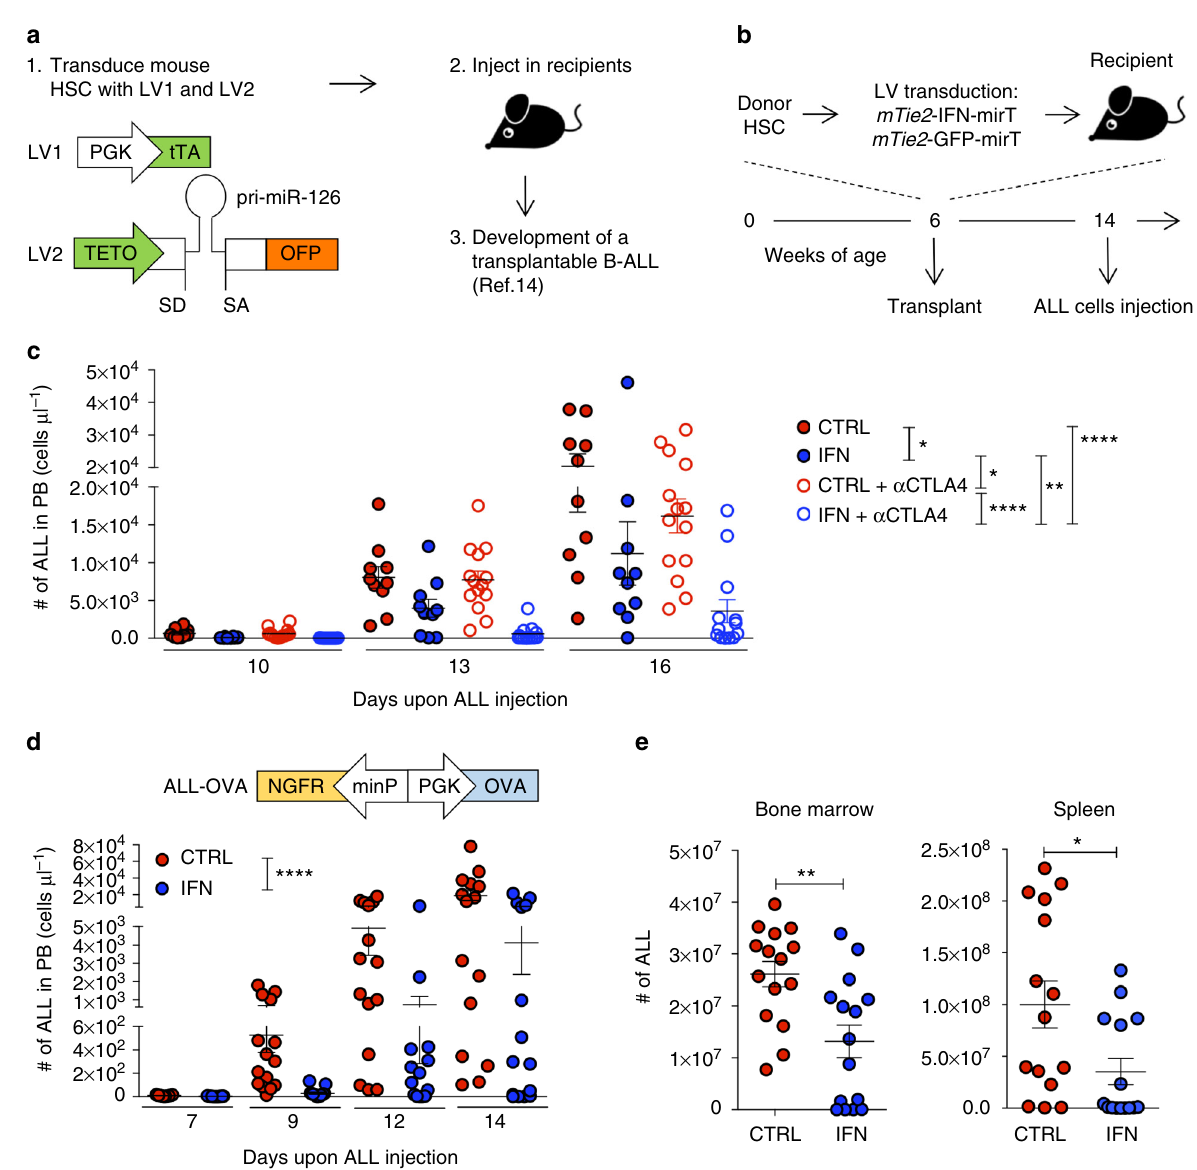
Fig. 1 IFN gene therapy inhibits ALL growth. a Schematic representation of the lentiviral vectors (LV) used to engineer HSC and generate spontaneous B- ALL. b Experimental design. c Absolute numbers (mean ± SEM) of parental ALL in the peripheral blood (PB) over time of CTRL ( n = 10, treated with isotype control antibody), IFN ( n = 10, treated with isotype control antibody), CTRL + α CTLA4 ( n = 14) and IFN + α CTLA4 ( n = 13) mice. Each dot represents a mouse. * p < 0.05, ** p < 0.01, **** p < 0.0001, nonparametric rank-based method for longitudinal data in factorial experiments. d , e Absolute numbers (mean ± SEM) of OVA-ALL (engineered with the NGFR/OVA bidirectional LV shown on the left) in the PB ( d ) over time and in BM and spleen ( e , 14 days after tumor injection) of IFN ( n = 15) and CTRL ( n = 15) mice (one out of 9 experiments is shown). Each dot represents a mouse. **** p < 0.0001, nonparametric rank-based method for longitudinal data in factorial experiments; * p < 0.05, ** p < 0.01, Mann –